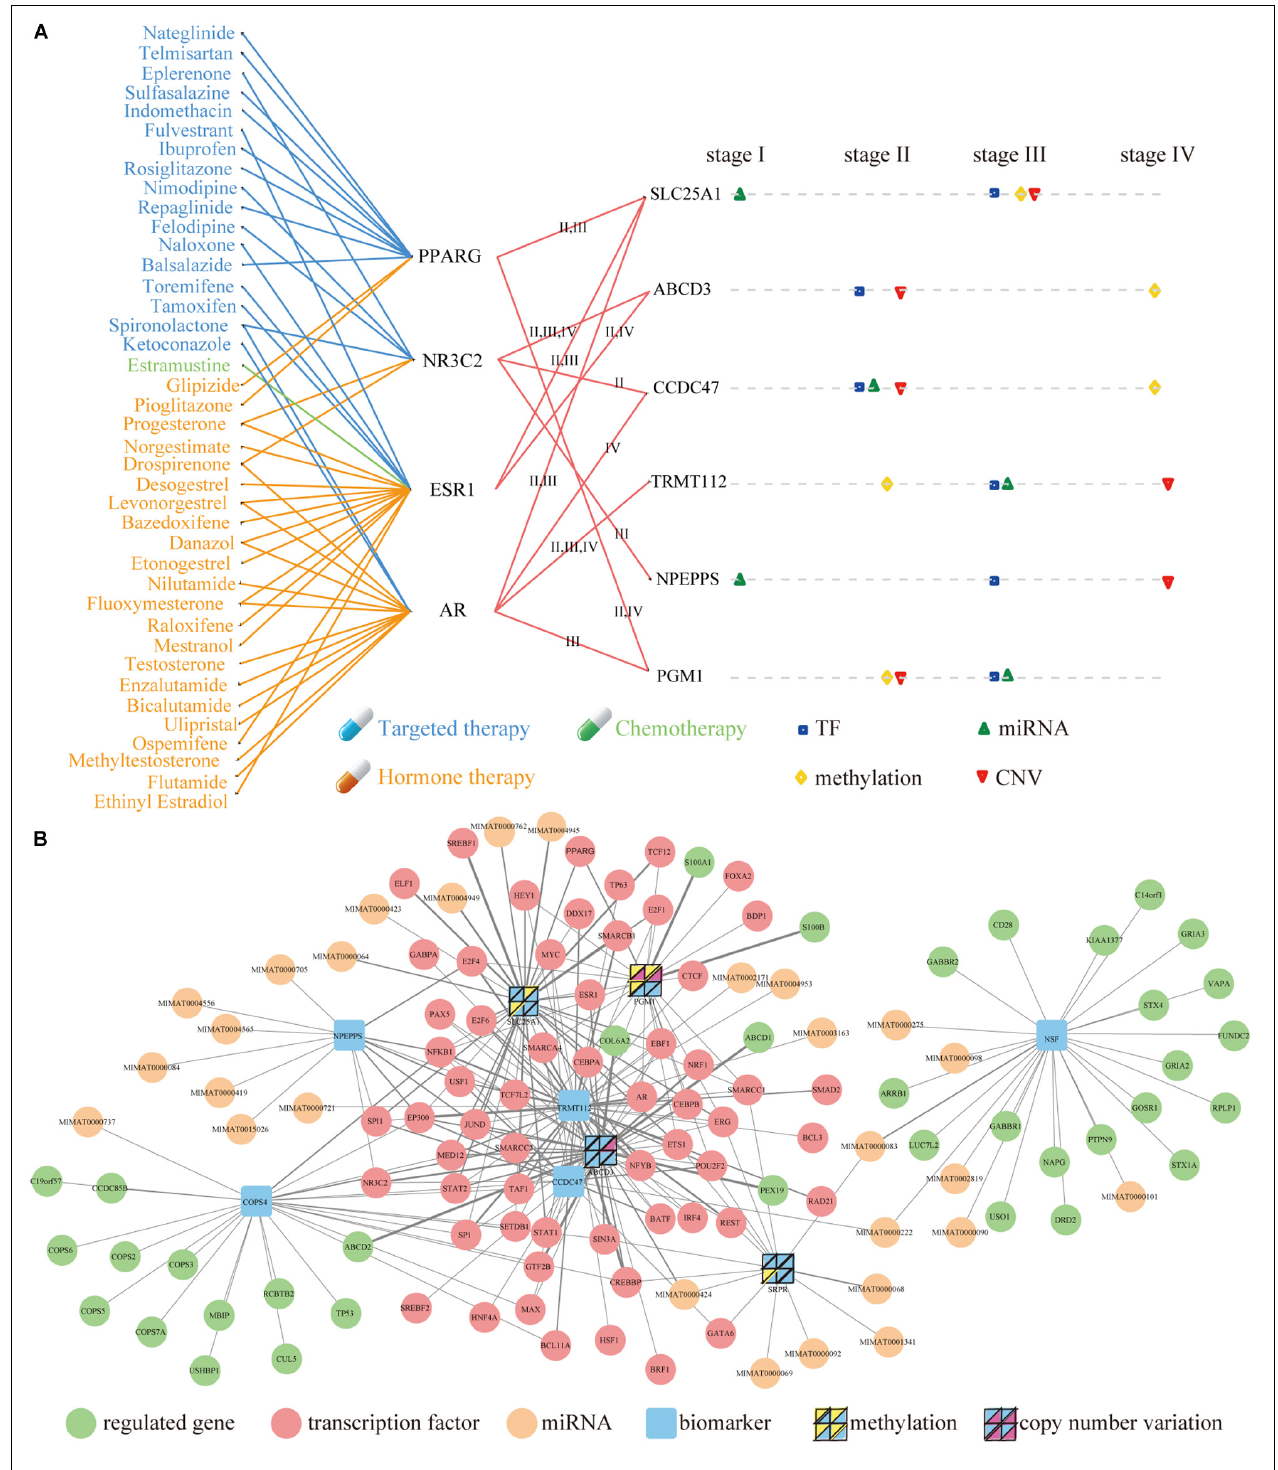
FIGURE 6 | Molecular Signatures and upstream and downstream network of nine biomarkers in COAD. (A) The mapping between FDA-approved drugs and their related genes (left) and the influence of four factors to the nine genes (right). The blue, green and orange lines represent targeted therapy, chemotherapy and hormone therapy respectively. Square, top triangle, diamond and bottom triangle represent the regulation of TF, miRNA, methylation and CNV on related genes in four stages. (B) Upstream and downstream network. The thickness of the line represented the quantity of interactions in these stages. The yellow and purple triangles (inside the four panel squares) represent that the nine genes are affected by their own methylation and CNV. Each panel in the four-panel squares represents each of the four cancer stages (top left is stage I, top right is stage II, bottom left is stage III, and bottom right is stage IV).